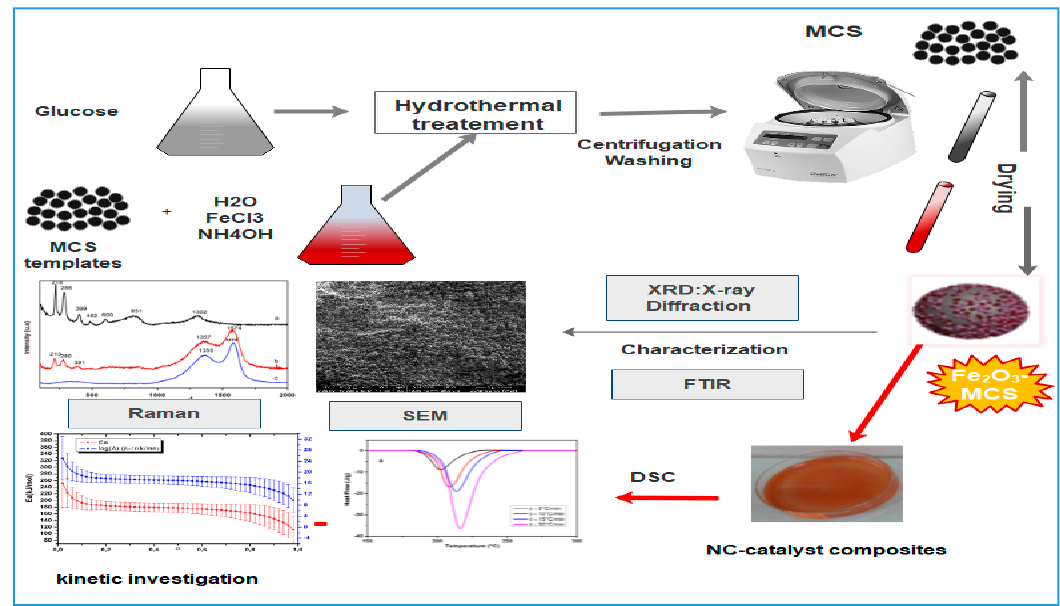
Figure 1. Schematic illustration of preparation and characterization of carbon mesosphere (CMS) and Fe 2 O 3 -CMS composites.